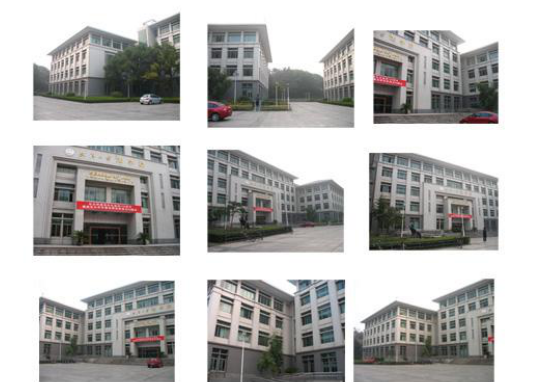
Figure 5: Point transfer (green crosses)